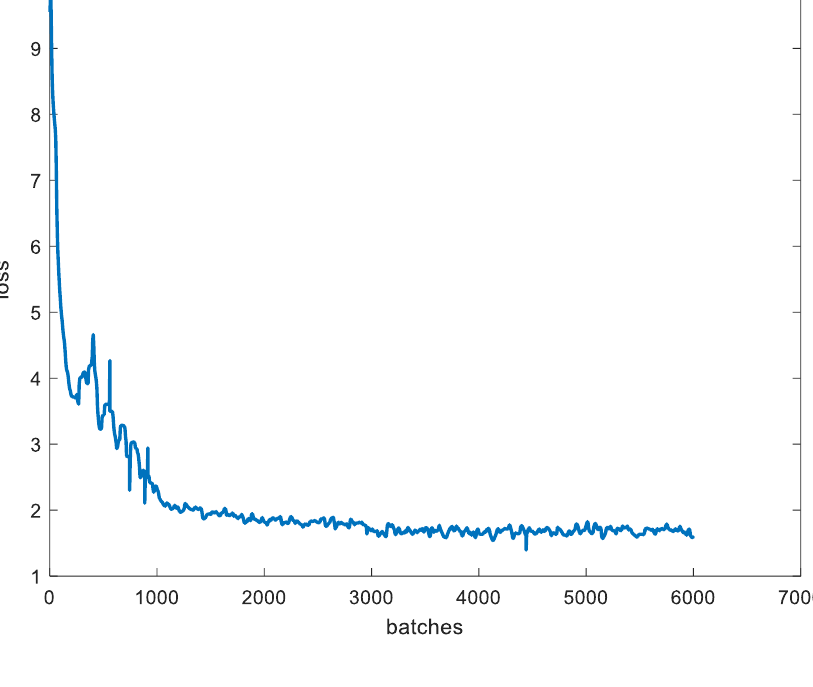
Figure 15. The training loss